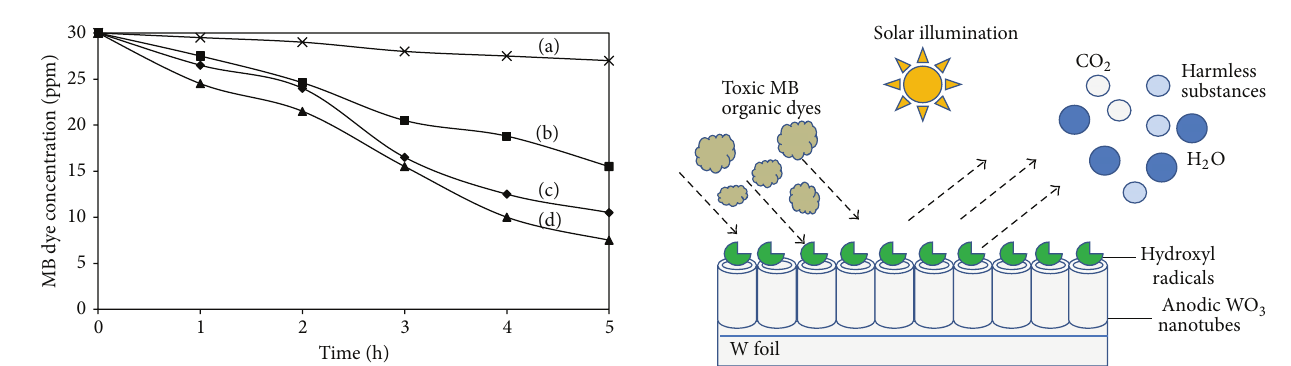
Figure 5: Photocatalytic degradation of MB dye solution under solar illumination, (a) blank sample (without anodic sample); (b) sample A (10min); (c) sample C (30min); and (d) sample B (15min).